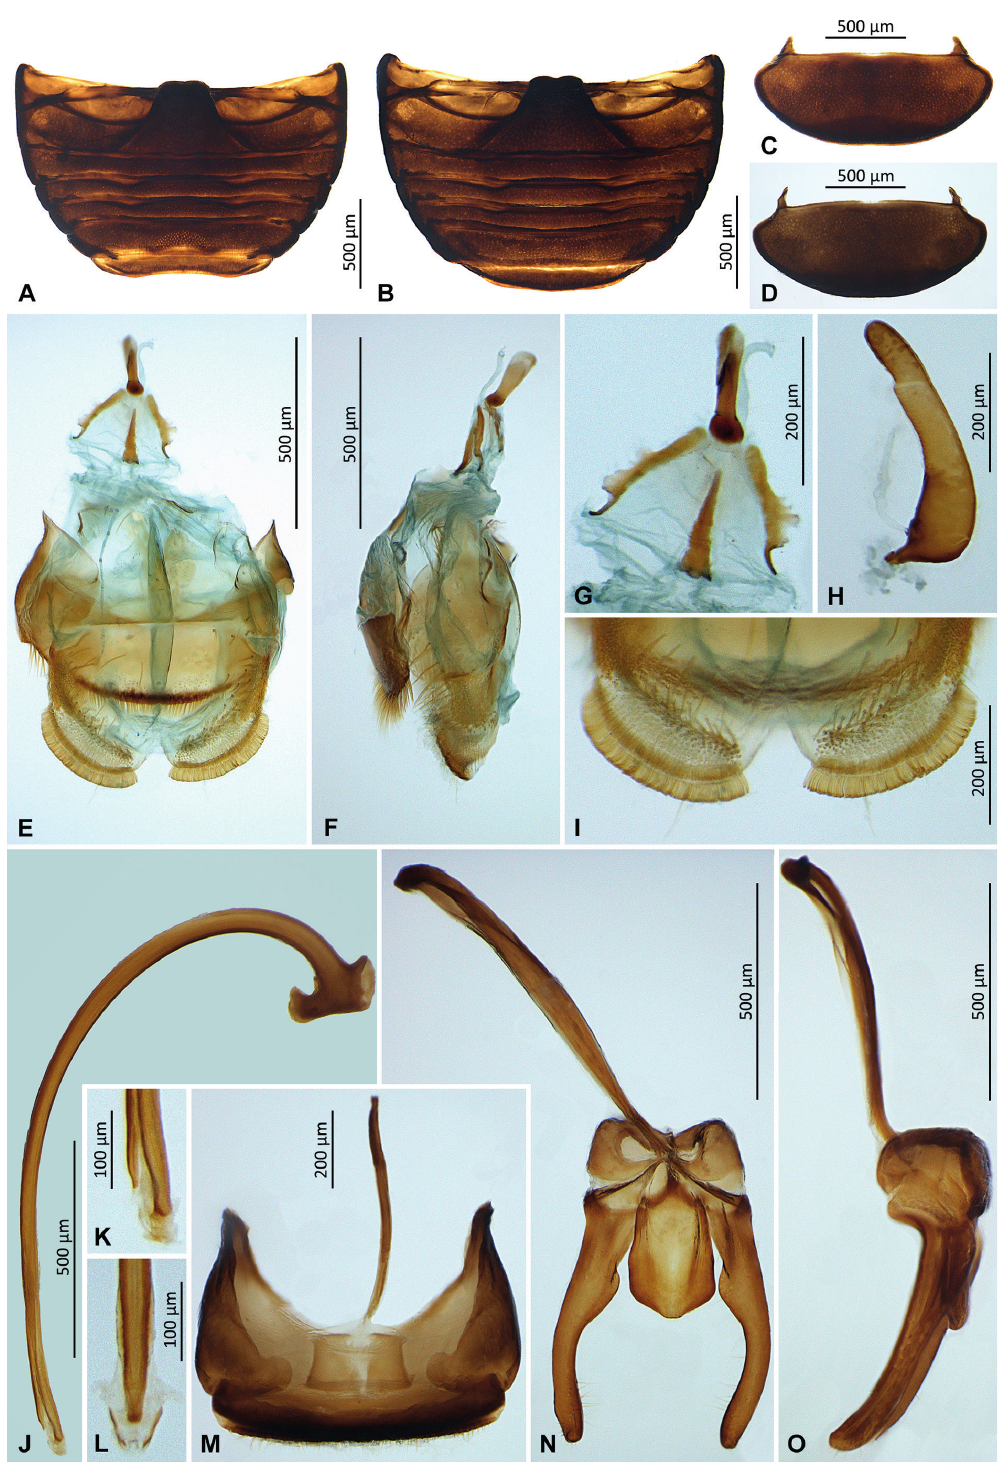
Fig. 4. Hinda ecuadorica Gordon & Canepari, 2013 (MIZ). A . ♂, abdomen. B . ♀, abdomen. C . ♂, tergite VIII. D . ♀, tergite VIII. E . ♀, genitalia, ventral view. F . ♀, genitalia, lateral view. G . Internal sclerites in bursa copulatrix. H . Spermatheca. I . Coxites, ventral view. J . Penis, lateral view. K . Penis tip, lateral view. L . Penis tip, inner view. M . ♂, segments IX and X, dorsal. N . Tegmen, inner. view O . Tegmen, lateral